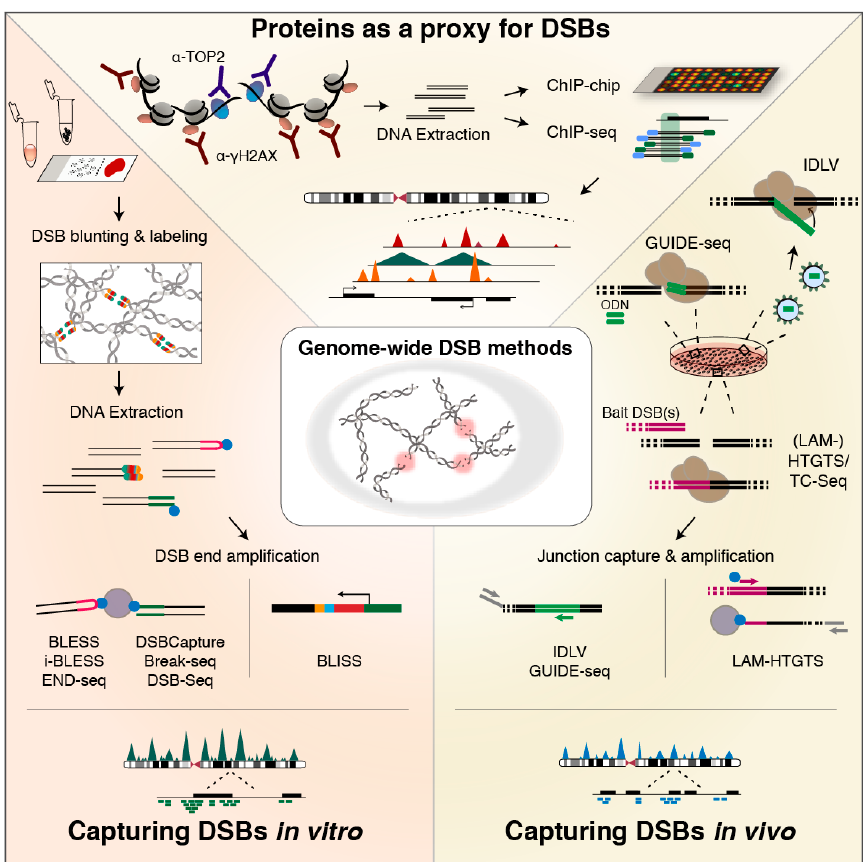
Figure 2. Methods for genome-wide DSB profiling. ( TOP ) Proteins recruited to DSB sites—or associated with DSB formation—serve as a proxy for DSB formation. Chromatin containing the protein of choice is pulled down, and the extracted DNA—representing the underlying genomic regions—can then be analyzed by microarray (ChIP-chip) or high-throughput sequencing (ChIP-seq) [183,187]. The resolution of the generated binding profiles typically depends on the chosen protein. ( RIGHT ) Methods for in vivo capturing of DSBs utilize the non-homologous end-joining (NHEJ) repair machinery of the cell to either incorporate short dsDNA oligos (ODN) (in genome-wide unbiased identification of DSBs enabled by sequencing, GUIDE-seq [194]), or integration-deficient lentiviral vectors (in IDLV capture [195,196]) at the genomic sites of DSBs, or to generate translocation junctions between emerging DSB ends and a bait DSB, exogenously introduced and then induced in the cell (translocation-capture sequencing (TC-Seq) and high-throughput genome-wide translocation mapping (HTGTS) or linear amplification-mediated (LAM)-HTGTS, and derived methods [197–200]). Afterwards, cells are lysed and DNA is isolated, followed by method-specific approaches for specific amplification or capture of integration or translocation junctions. Subsequently, sequencing libraries are prepared, and sequence reads are aligned to the genome, typically revealing breakpoint clusters genome-wide. ( LEFT ) In vitro methods for genome-wide DSB identification directly label DSB ends with a dedicated adapter—with or without prior DSB end processing—in fixed cells immobilized on a surface (Breaks Labeling In Situ and Sequencing, BLISS [201]) or fixed cell suspensions (Breaks Labeling, Enrichment on Streptavidin, and Sequencing, BLESS [122]), in unfixed cells embedded in agarose plugs or beads (END-seq [202] and i-BLESS [203], respectively), in isolated DNA (DSB-Seq [126]), or isolated DNA in agarose plugs (Break-seq [204]). After labeling, DSB ends are selectively linearly amplified by in vitro transcription enabled by the BLISS adapter in BLISS. In the other methods, DSB ends are captured onto streptavidin beads that selectively capture the biotin-labeled DSB ends, and then amplified. Finally, sequencing libraries are prepared and the resulting mapped sequence reads reveal single DSB ends distributed